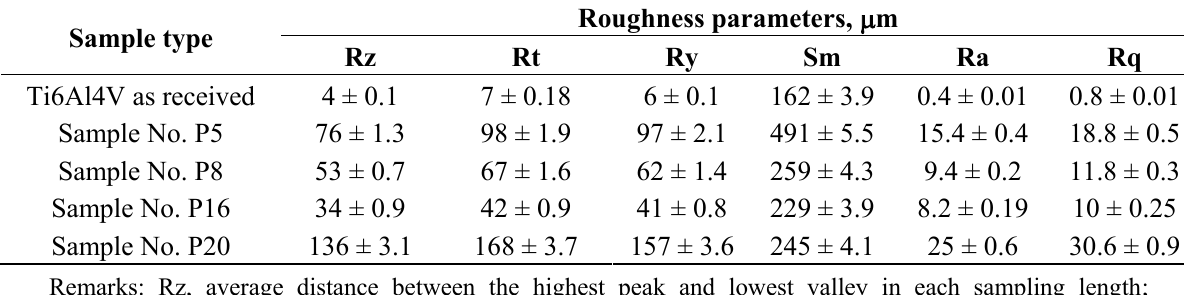
Table 3. Results of roughness measurements on the surface of titanium alloy Ti6Al4V specimen and on the nitrided surface layers (Table 2).